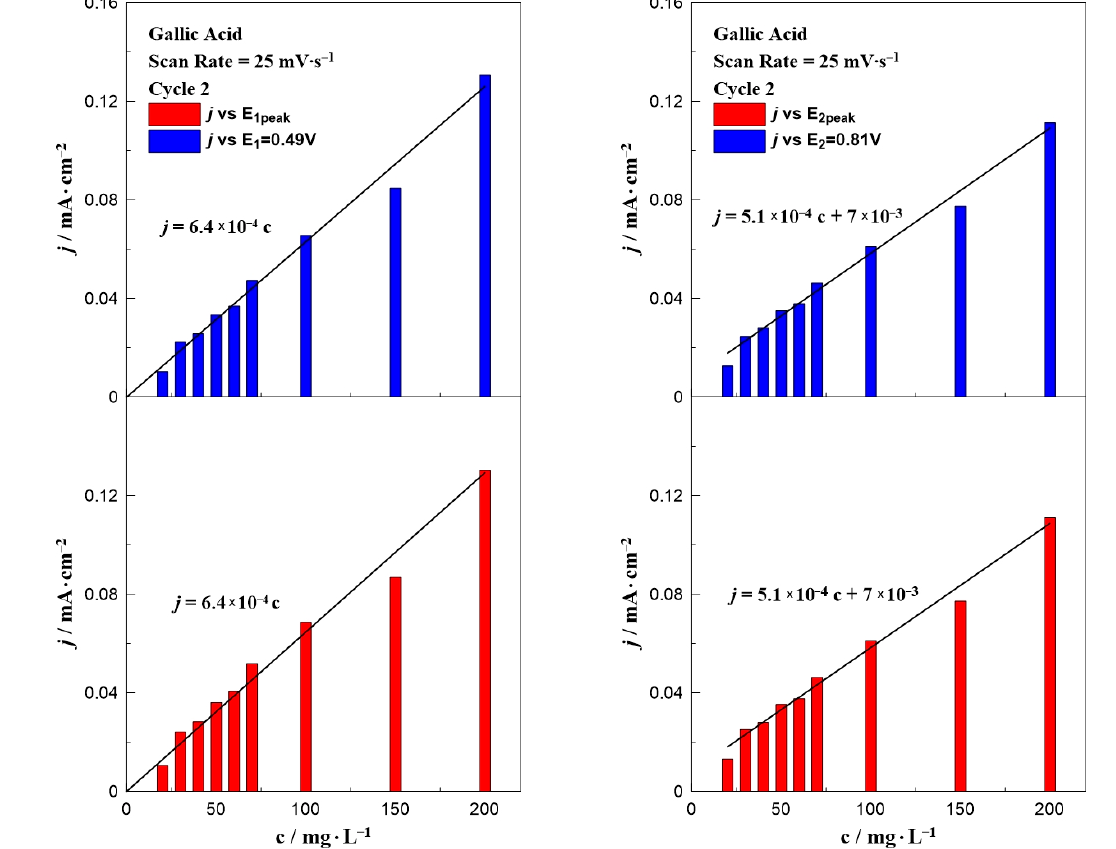
Figure 3. Effect of gallic acid concentration on the current density value at E 1 and E 1, peak ( left ) and E 2 and E 2, peak ( right ) at a constant scan rate of 25 mV · s − 1